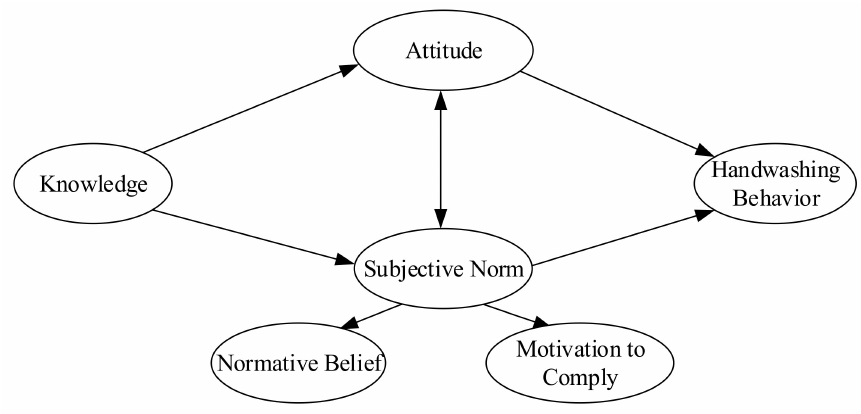
Figure 1. Hypothetical